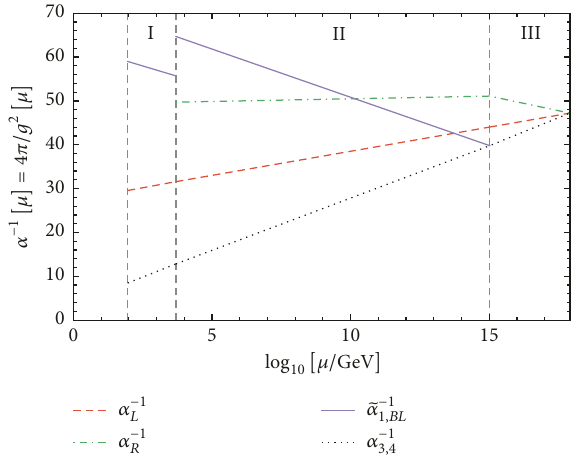
Figure 1: Running of the gauge couplings for the model. The vertical dotted lines from left to right correspond to the symmetry breaking scales 𝑀 𝑍 , 𝑀 𝑅 , and 𝑀 𝐶 , which also indicate the beginning of the energy intervals I, II, and III, respectively. For 𝛼 −1 1 and 𝛼 −1 𝐵𝐿 , we plot the redefined quantities ̃𝛼 −1 1 ≡ (3/5)𝛼 −1 1 and ̃𝛼 −1 𝐵𝐿 ≡ (3/2)𝛼 −1 𝐵𝐿 . Note that the discontinuity on the ̃𝛼 −1 1,𝐵𝐿 plot at the energy scale 𝑀 𝑅 occurs due to the boundary condition given in (6).